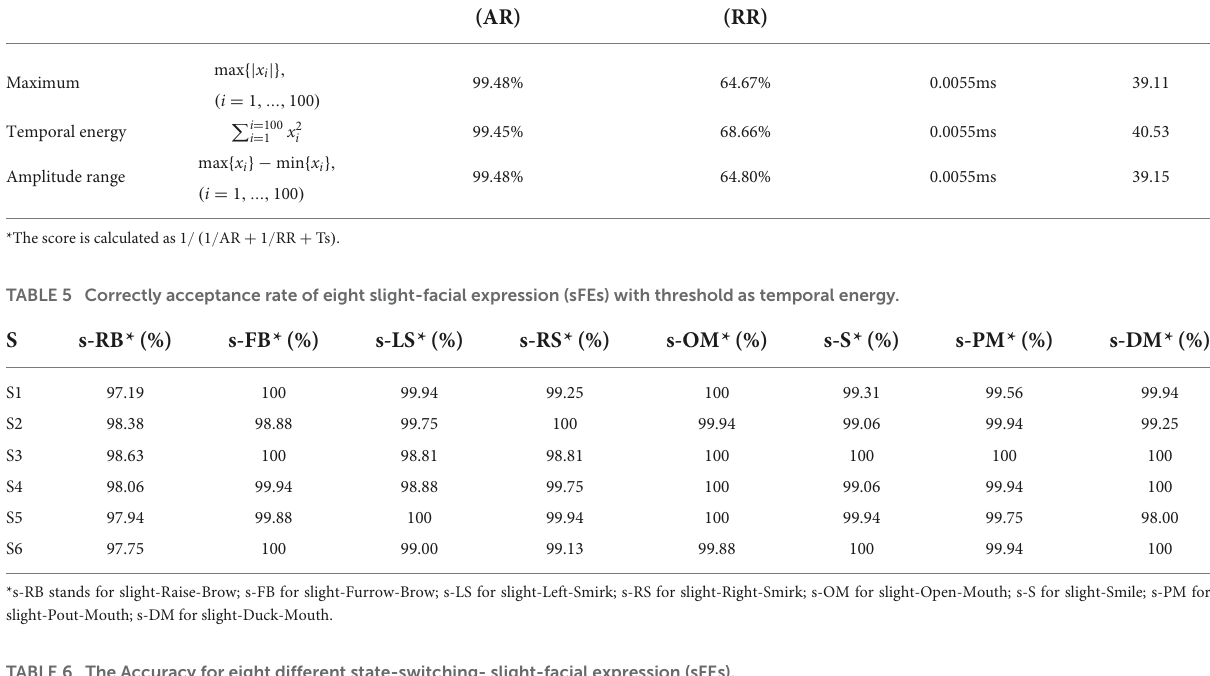
TABLE 6 The Accuracy for eight different state-switching- slight-facial expression